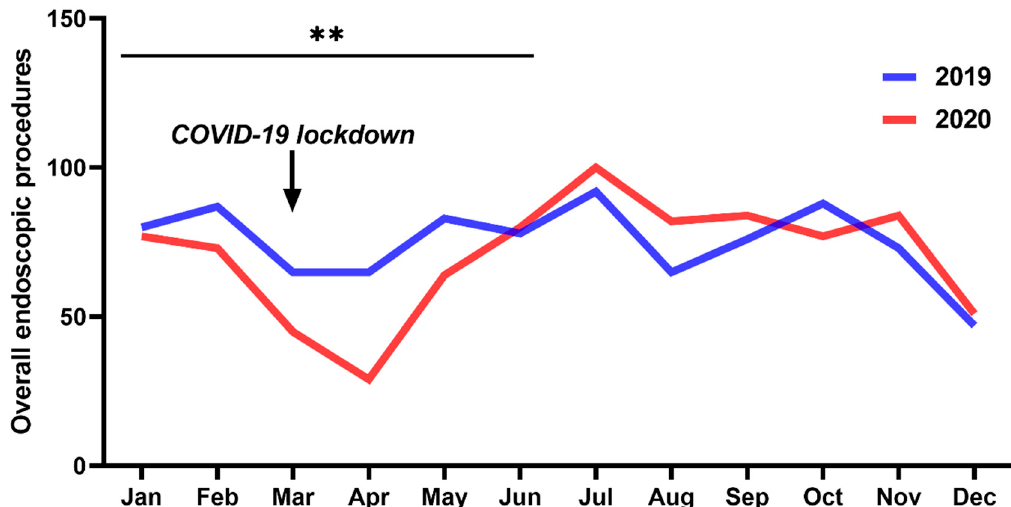
Figure 1. Overall frequency of diagnostic and therapeutic bladder cancer procedures performed during 2020, compared with 2019. ** p < 0.01.